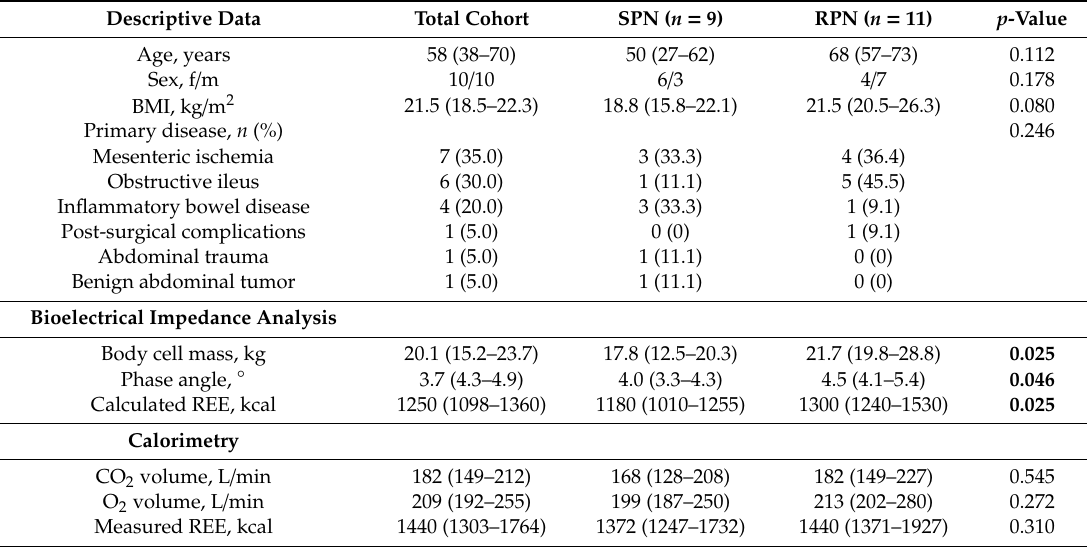
Table 1. Baseline